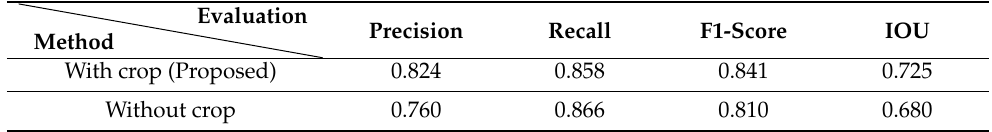
Table 5. Performance between model with crop and without crop.